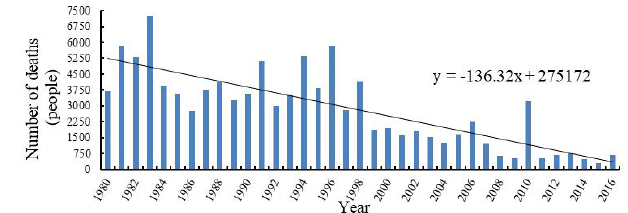
Figure 4. Direct economic losses caused by flood from 1990–2016 (MWR,